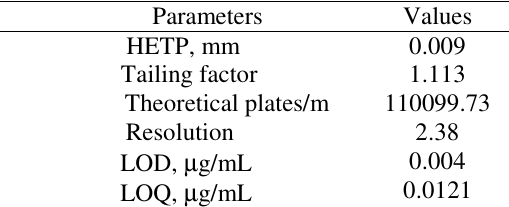
Table 2. System suitability test parameters